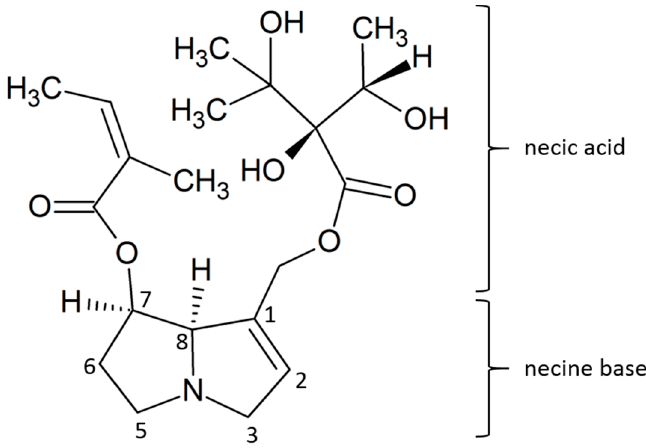
Figure 1. Structure of echimidine (image modified from [42]), the most abundant pyrrolizidine alkaloid (PA) in its N -oxide form in Echium plantagineum and E. vulgare . The unsaturated bond between positions 1 and 2 induces toxicity. Reversible oxidation of nitrogen at position four alters chemical properties. Side chains at positions 1 and 7 vary between analyzed alkaloids. A thorough review of PAs was published previously and is referred to for additional information [20].